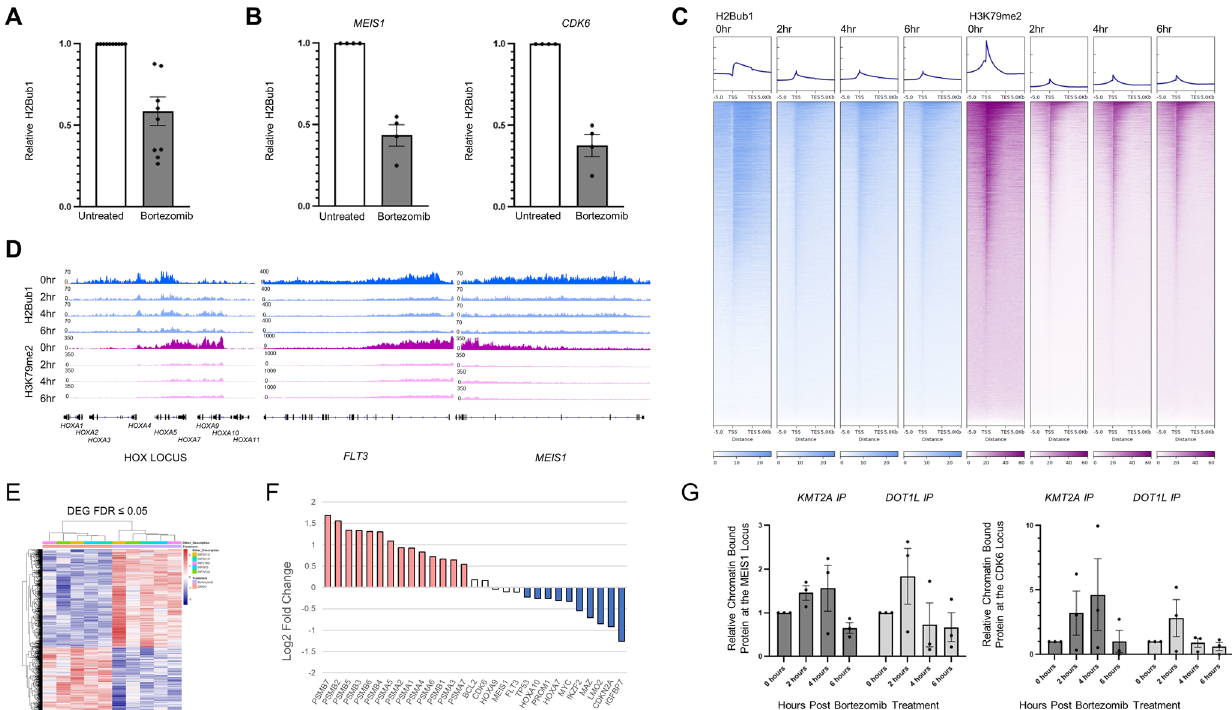
HOXA1-A11 , FLT3 , and MEIS1 gene loci. E Five patient specimens were grown in the presenceorabsenceof5nMbortezomibfor20hfollowedbyRNAextractionfrom 2millionlivecellsandsequencing.Cellswereanalyzedat20hbasedonthehalf-life of mRNA which is 10h. A heatmap of differentially expressed genes is shown. F Log2 fold change of proteasome complex transcripts, KMT2Artarget genes, and the cMYC target genes TP53 and CDKN2A are shown following exposure to bor- tezomib. The upregulation of proteasome complex genes demonstrates target inhibition. G The KMT2Ar infant ALL cell line (SEM) was grown in the presence or absence of bortezomib. CUT&RUN reactions at 0, 2, 4, and 6h following exposure to bortezomib was done with an N-Terminal KMT2A antibody and DOT1L. Quan- titative PCR for two KMT2A target genes, MEIS1 and CDK6 was determined. Fold change over IgG was calculated and untreated specimens were set to one. The averageacrossfourindependentexperimentsareshownwiththestandarderrorof the mean. Source data are provided as a Source data fi